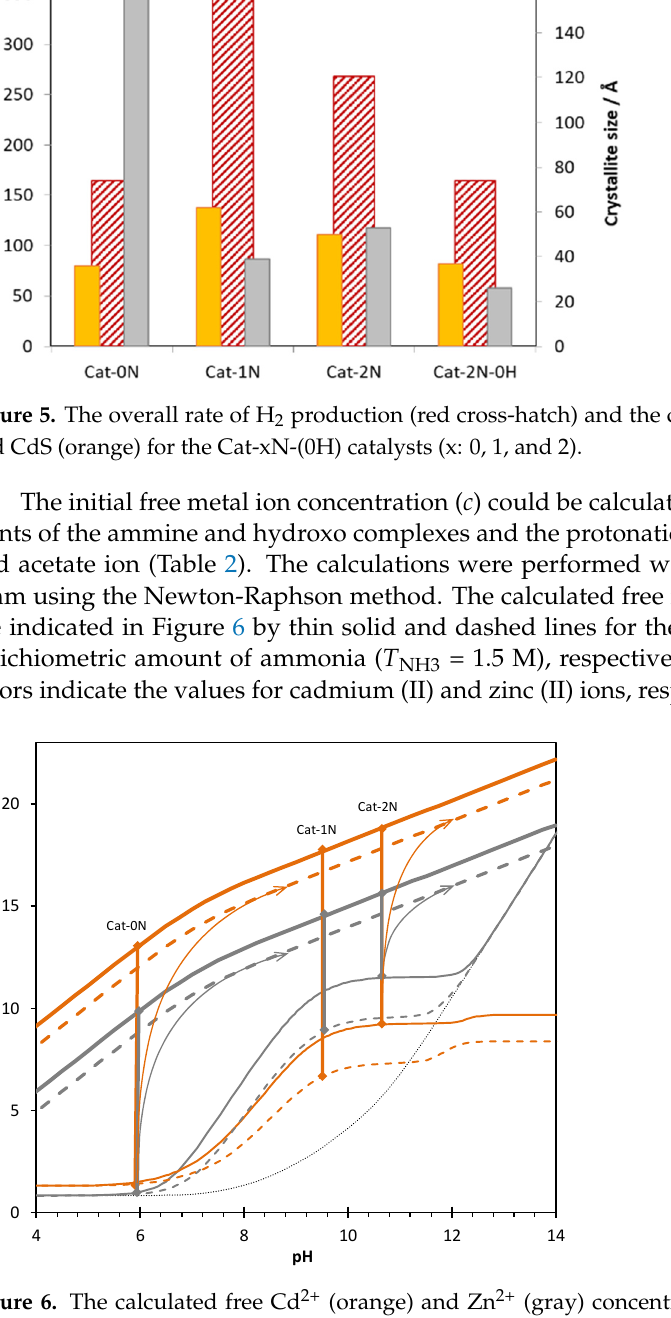
Figure 6. The calculated free Cd 2+ (orange) and Zn 2+ (gray) concentrations. The thin solid and dashed lines represent the values for 0.15 M total Zn 2+ and 0.05 M total Cd 2+ concentration for the excess ( T NH3 = 3 M) and stoichiometric amount of ammonia ( T NH3 = 1.5 M), respectively. The thick solid and dashed lines show the free equilibrium concentration at 0.22 M and 0.02 M total sulfide concentration, respectively. The thin dotted line shows the free Zn 2+ concentration, taking only the formation of hydroxo complex into account. For the meaning of the vertical lines and the arrows, see the text. Table 2. Overall stability constants used for the calculation of the initial free metal ion concentra- tions [42,43].